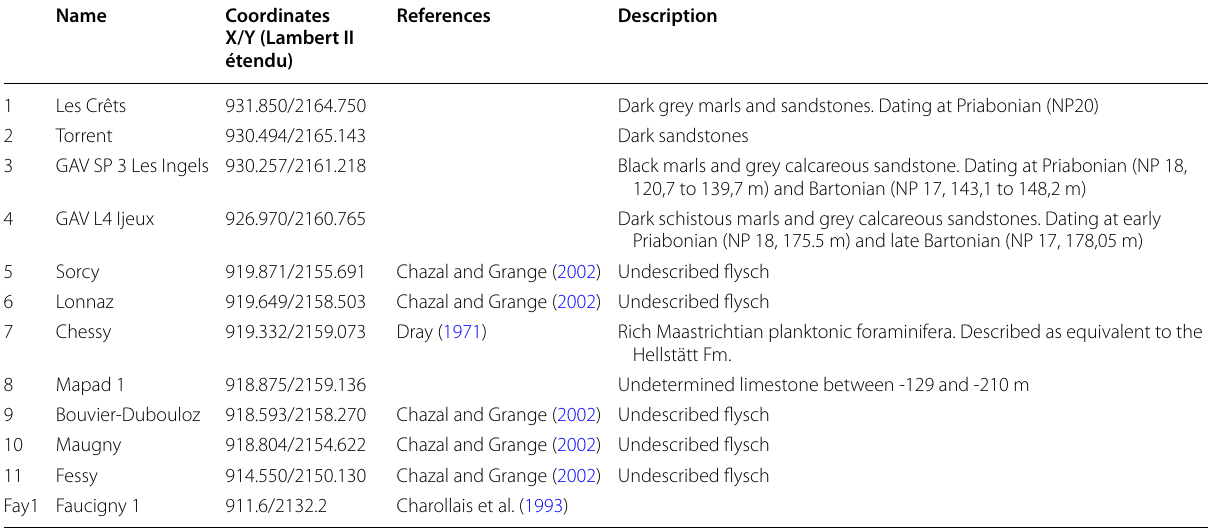
Table 2 General informations on the boreholes carried out in the Voirons Flysch and in the adjacent units from Dupuy et al.